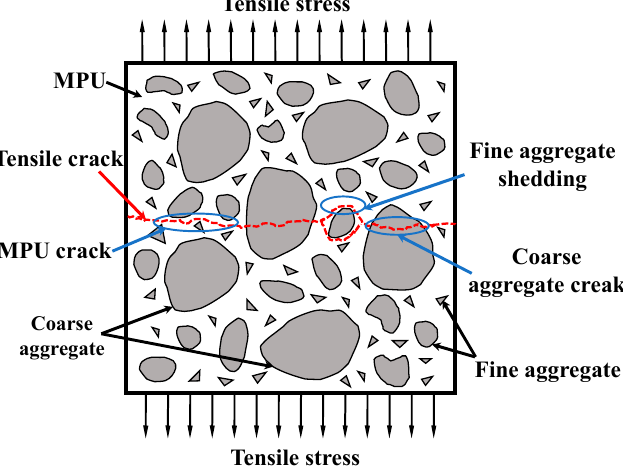
Figure 10. Schematic diagram of fracture section of specimen.